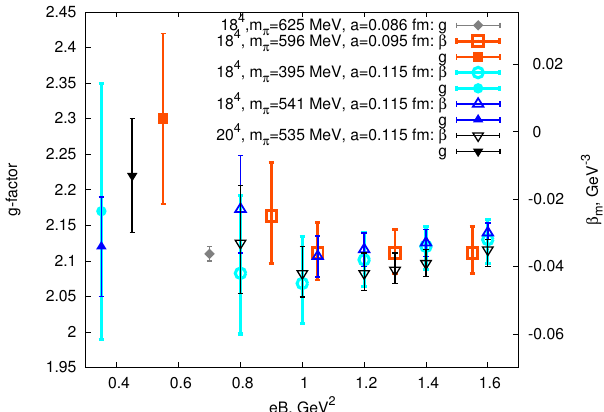
Figure 9. The g -factor and the dipole magnetic polarizability (cid:12) m depending on the interval of (cid:12)elds used for their determination for various lattices and pion masses.